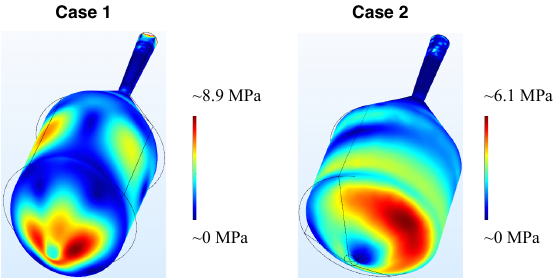
Figure 8. Von Mises stress for Case 1 ( left ) and Case 2 ( right ). The thermal expansion coefficients of [22] have been used. The thin black lines indicate the orginal size of the crystal. The displacements due to the different temperatures are visualized by the surface with the colours of the von Mises stress (deformation magnification factor, ( left ): 100; ( right ): 20).